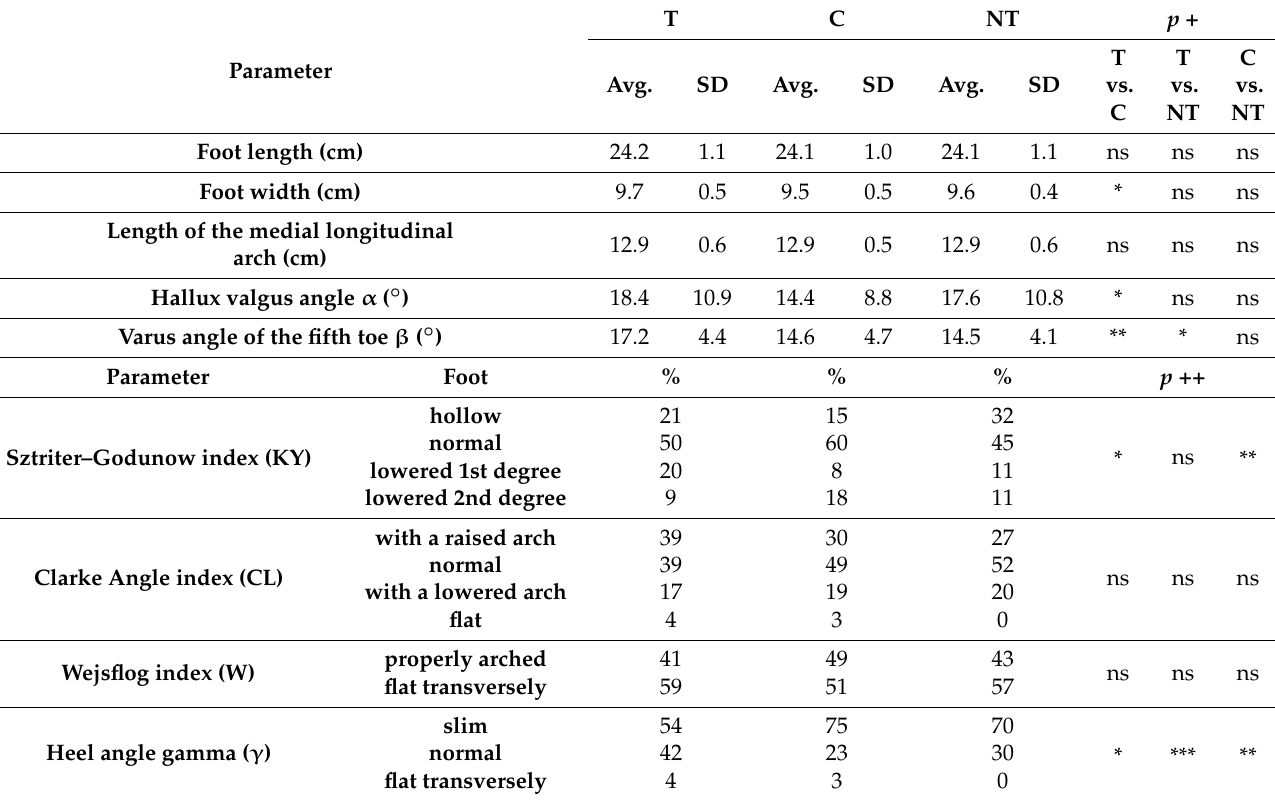
Table 2. Anthropometric parameters determined on the scanned image of the feet and the character- istics of the longitudinal and transverse arch of the feet based on the indexes obtained in podoscopic examination in groups T—treatment (N = 76); C—control (N = 80); NT—no treatment (N = 44).